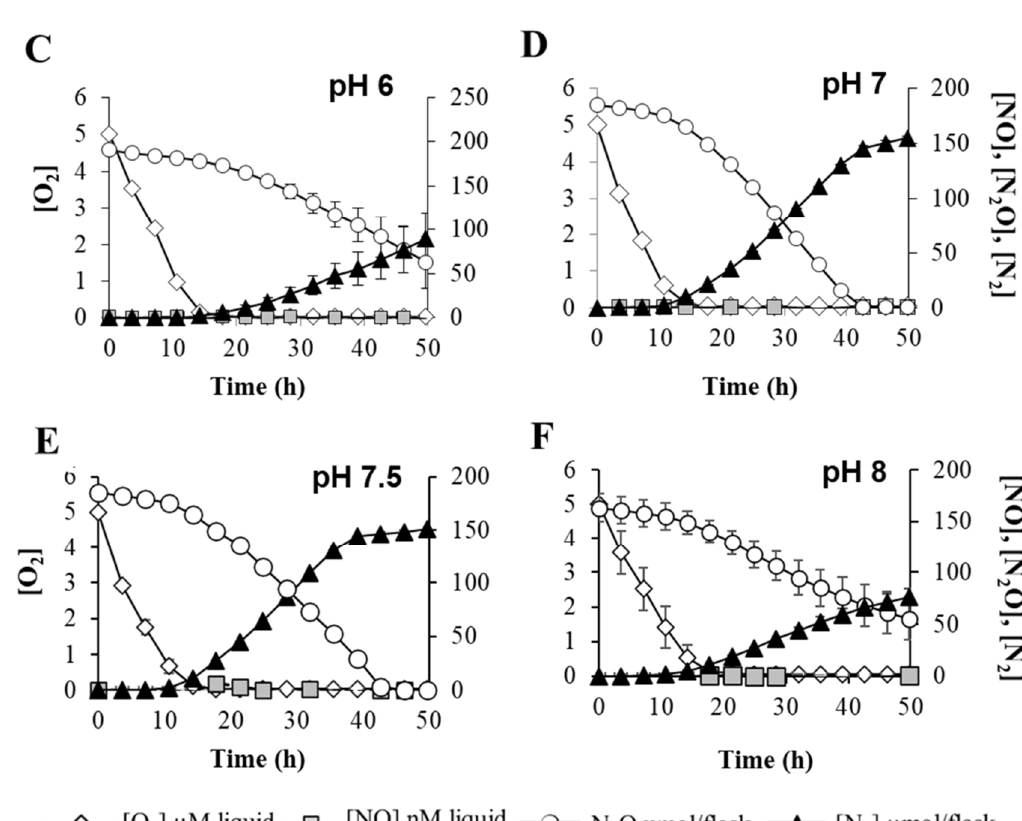
Figure 4. Impact of C-source and pH on N 2 O consumption. Measurement of O 2 and N 2 O respiration and concentrations of NO and N 2 . B. diazoefficiens 110 spc 4 parental strain was incubated in vials containing 0.5% O 2 , 5% N 2 O, and 10 mM NO 3 − as substrates for aerobic and anaerobic respiration, respectively. C-sources ( A , B ) and pH ( C – F ) of the growth medium were modified as shown on the graphs (see Material and Methods for further details). O 2 and NOx concentrations were monitored by automatic sampling from headspace phase. Data are the means and standard deviations of at least three different cultures.